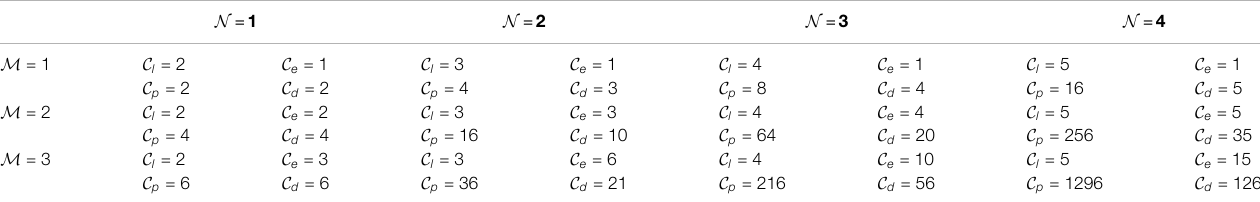
TABLE 1 | Overview of the total number of possible pathways for ionization with a given number of photons ( N ) from ( M ) pulses. Shown are the numbers of angular momentum states ( C l ), free electron energy states ( C e ), pathways ( C p ) and distinguishable pathways ( C d